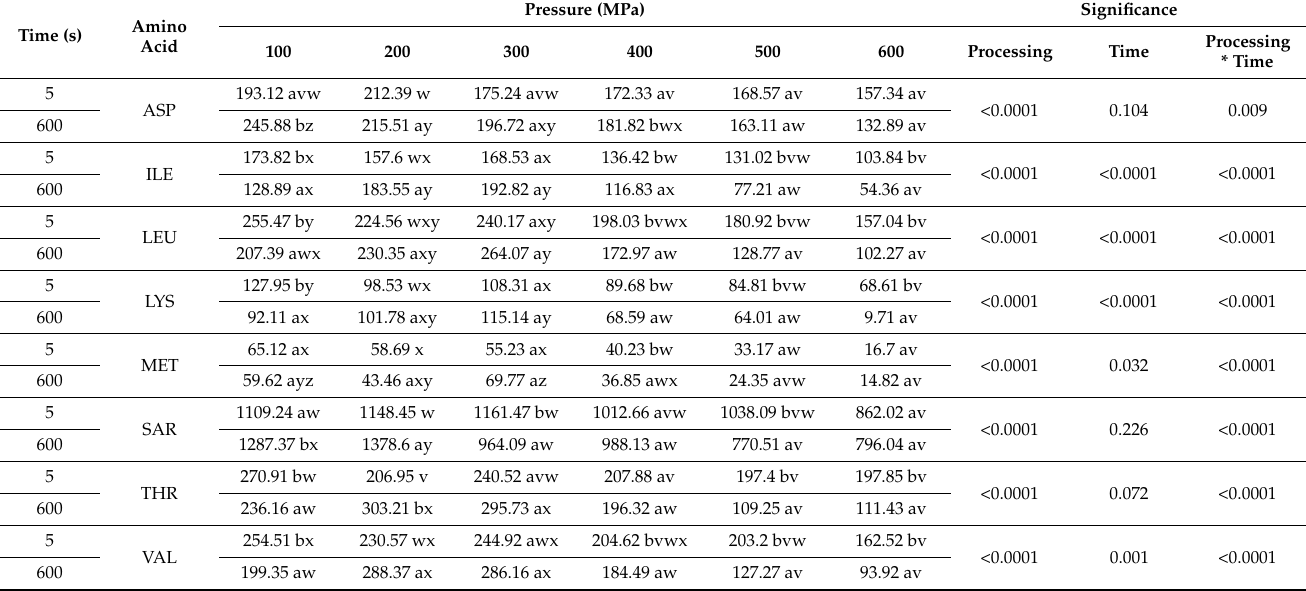
Table 5. Free amino acid composition of Tua Tua ( Paphies donacina ) clam. a,b means with different letters within a row show the significant effect of time with each processing pressure; v,w,x,y,z means with different letters within column show the significant effect of time under the same processing pressure. * Compounds identified with VID coefficients higher than